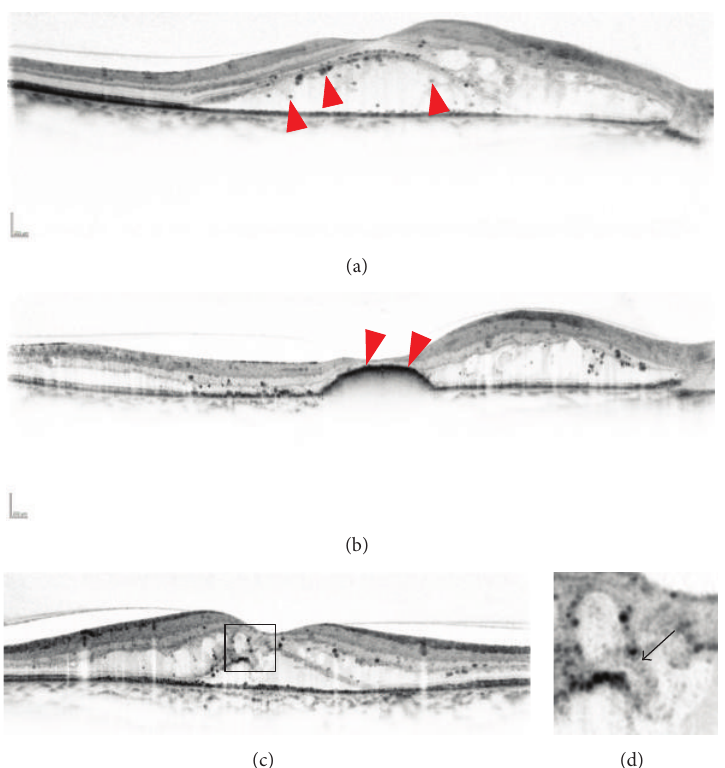
Figure 5: A representative case with hyperreflective foci (arrowheads) in subretinal fluids. The preoperative decimal VA is 0.6. (b) DME is improving after focal/grid photocoagulation, although hyperreflective foci have accumulated at the fovea (arrowheads). The postoperative VA is 0.09. (c) OCT sometimes shows that cystoid spaces in the OPL rupture to subretinal fluids (arrow), which might modulate the pathogenesis in SRD.